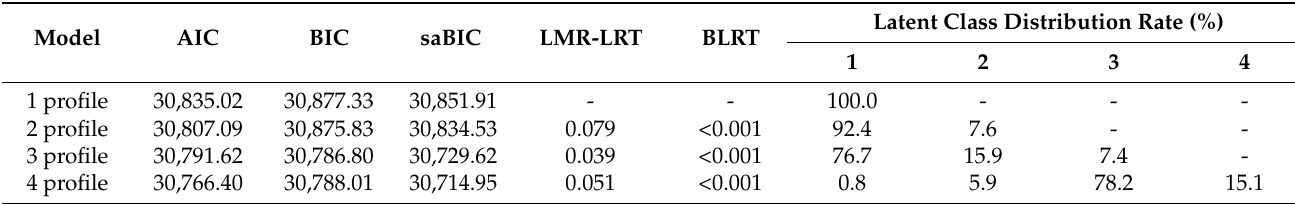
Table 2. Model fit of latent profile analysis of child-rearing attitude (5th wave).